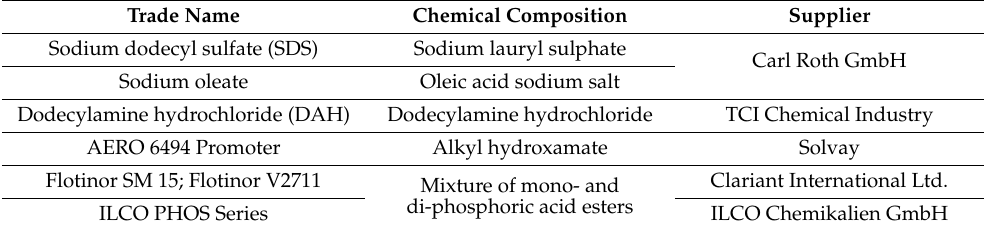
Table 2. Reagents used in the flotation experiments.